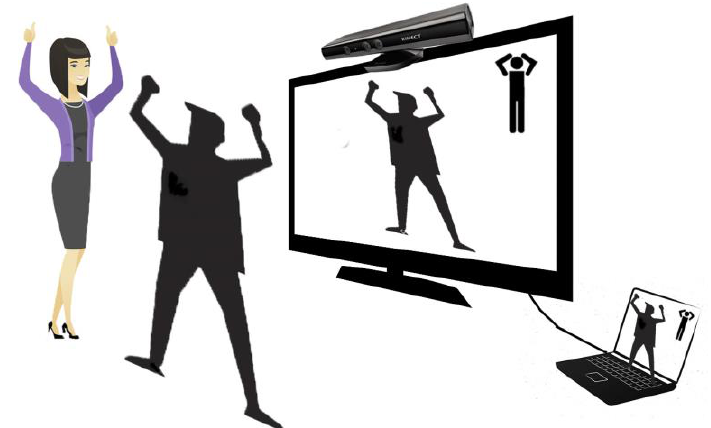
Figure 5. Set up for gesture testing sessions.